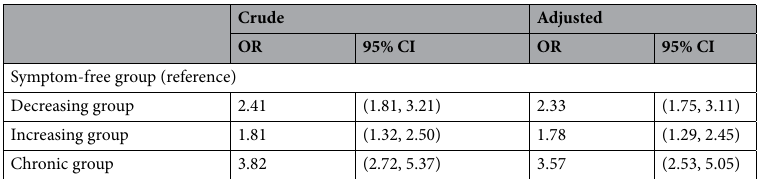
Table 3. Crude and fully adjusted multinomial models for the associations between reporting one or more traumatic childhood events and membership into each depression symptom trajectory group (n = 1844). OR = odds ratio. CI = confidence interval. Controlling for biological sex, age group, and self-reported race and ethnicity.